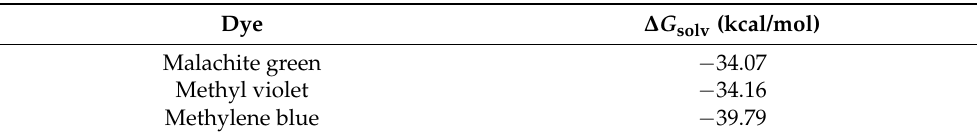
Table 2. Gibbs free energy of solvation for the three dyes used using the SMD model at the DFT/B3LYP/6-311+G(d,p) level.